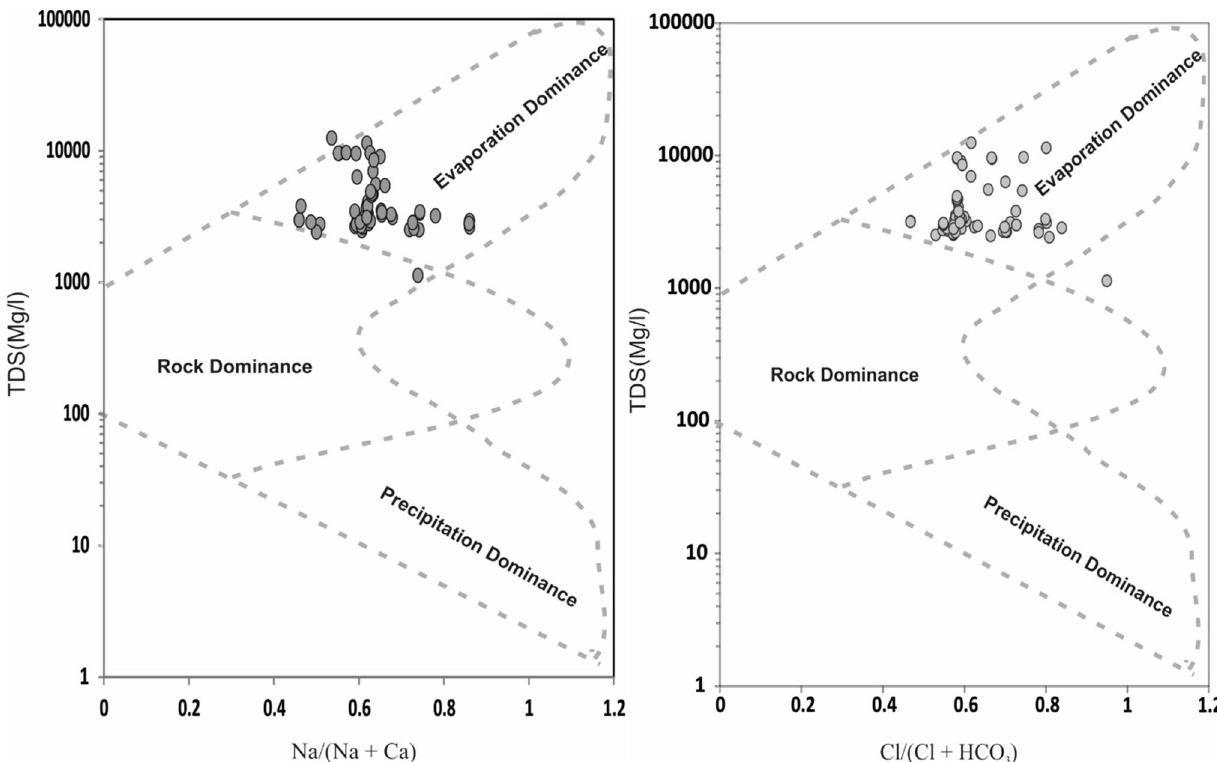
Fig. 11 Gibbs diagram for controlling factor of groundwater quality in the study